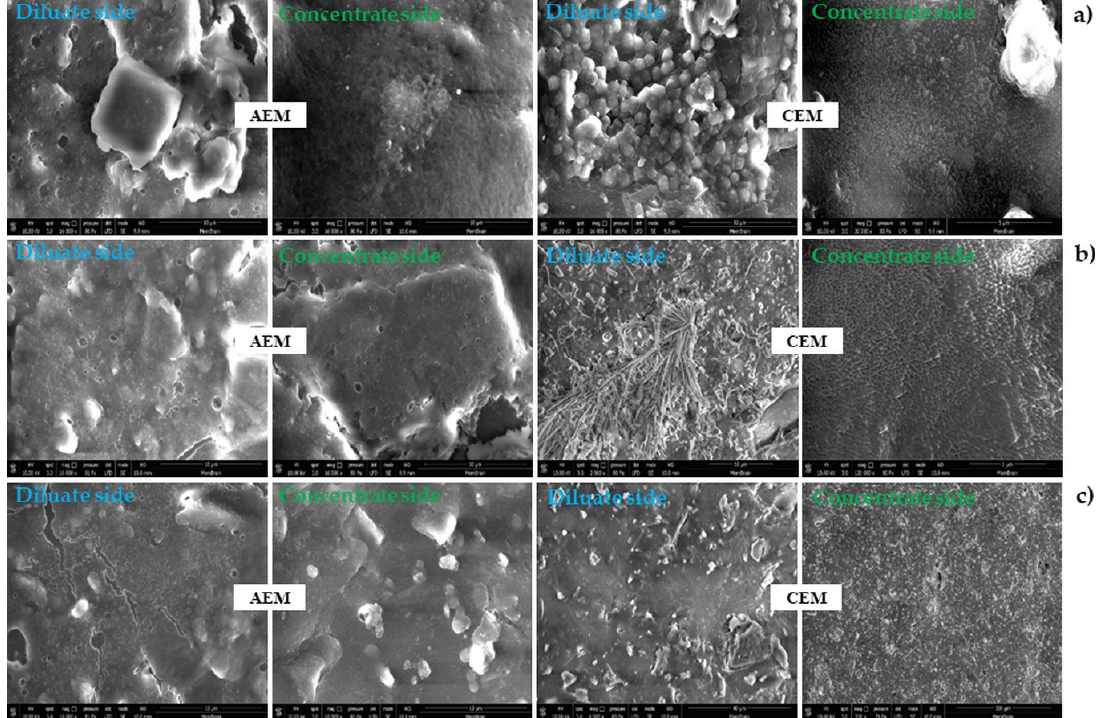
Figure 2. SEM images of the membranes after different regimes, ( a ) regime I, ( b ) regime II , ( c ) regime III , (AEM = anion exchange membrane, CEM = cation exchange membrane). 16000 × magnification